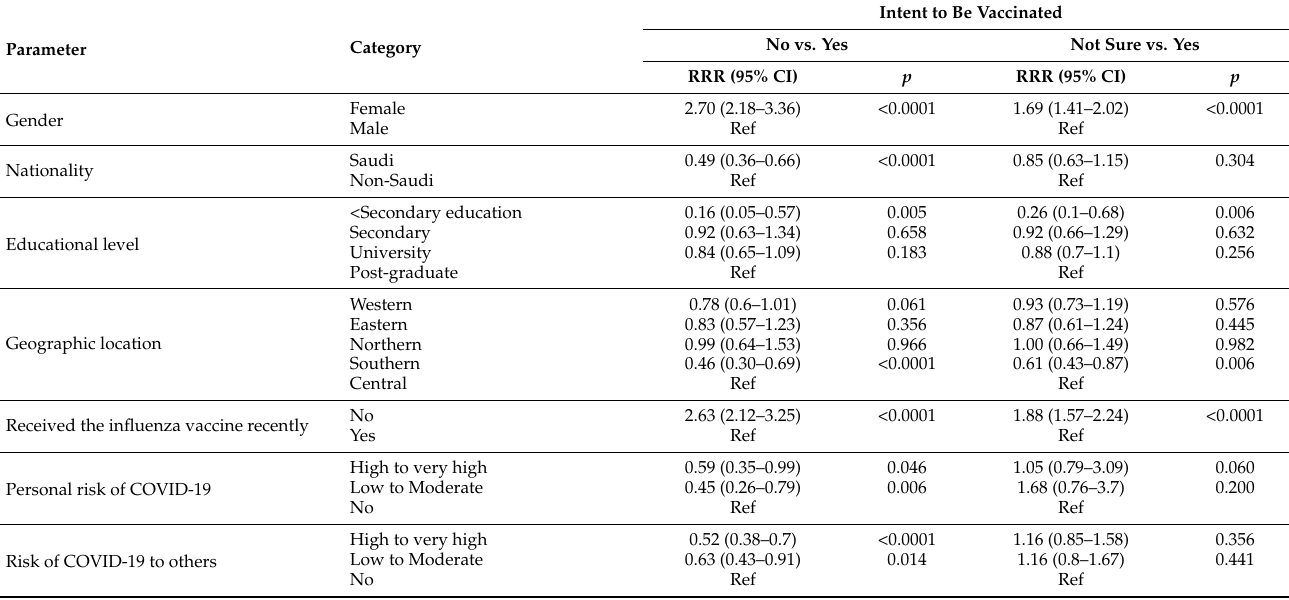
Table 3. Predictors of providing “no” and “unsure” responses regarding participants’ intent to get